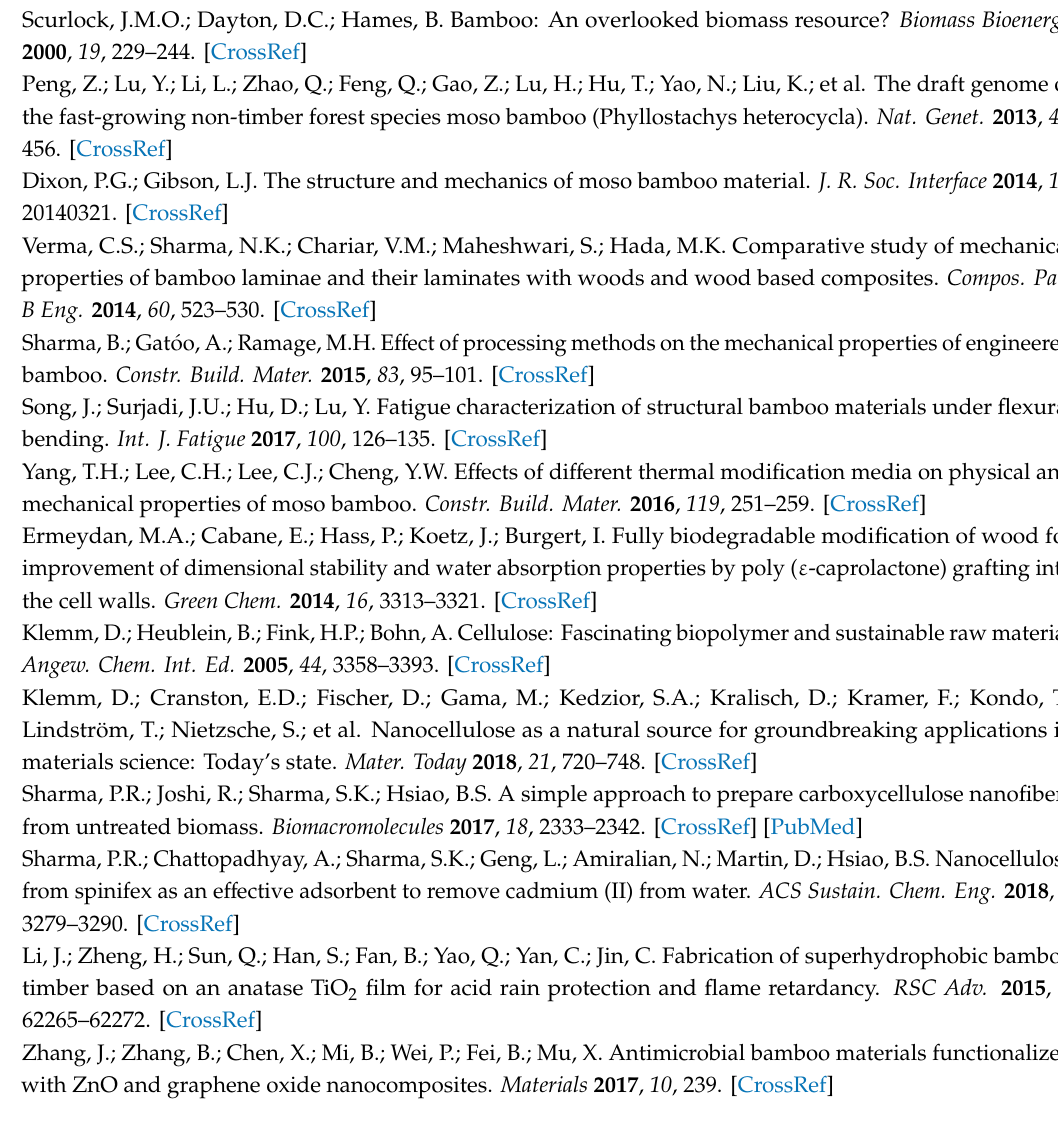
Figure S1: The specimen preparation procedure for nanoindentation. Figure S2: Characterization of FA resin and reaction of FA under acidic conditions: (a) FTIR spectra; (b) The possible reaction during furfurylation